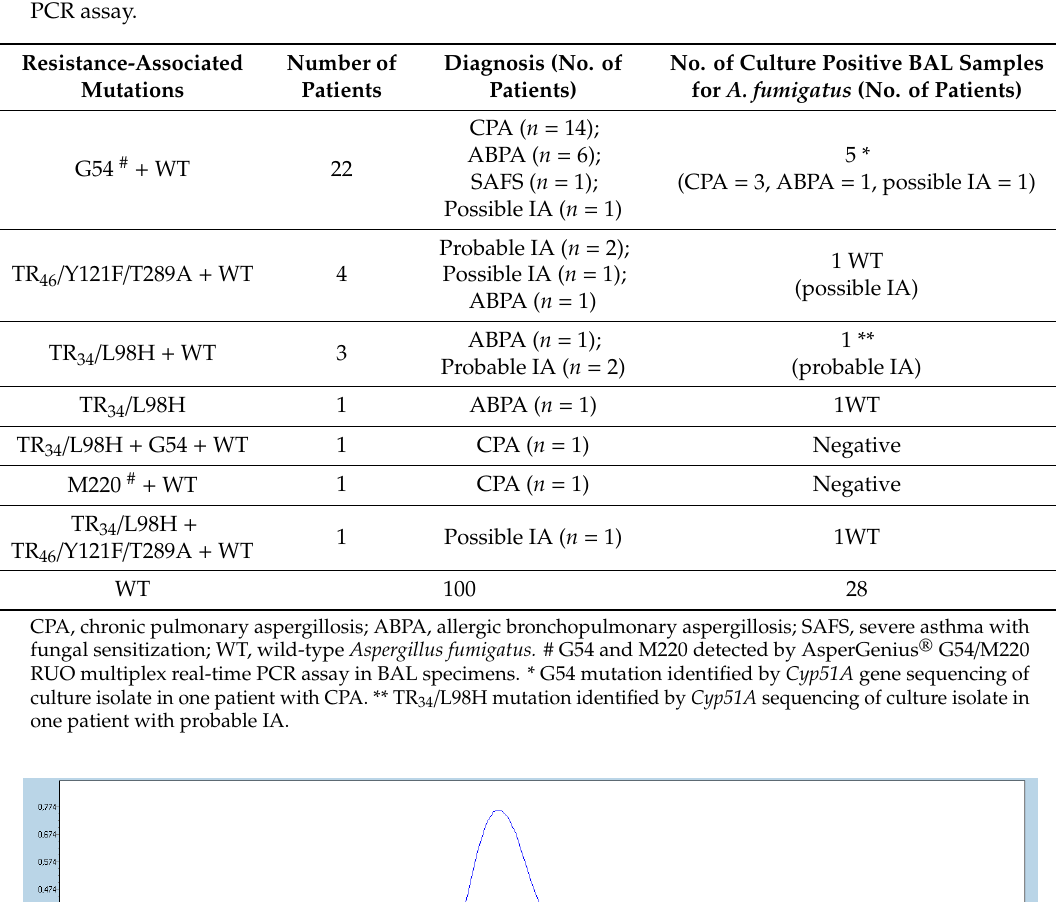
Table 1. Details of patients ( n = 33) positive for resistance-associated mutations detected in bronchoalveolar lavage (BAL) specimens by AsperGenius ® Resistance multiplex real-time polymerase chain reaction (PCR) assay and a newly developed AsperGenius ® G54 / M220 RUO multiplex real-time PCR assay.